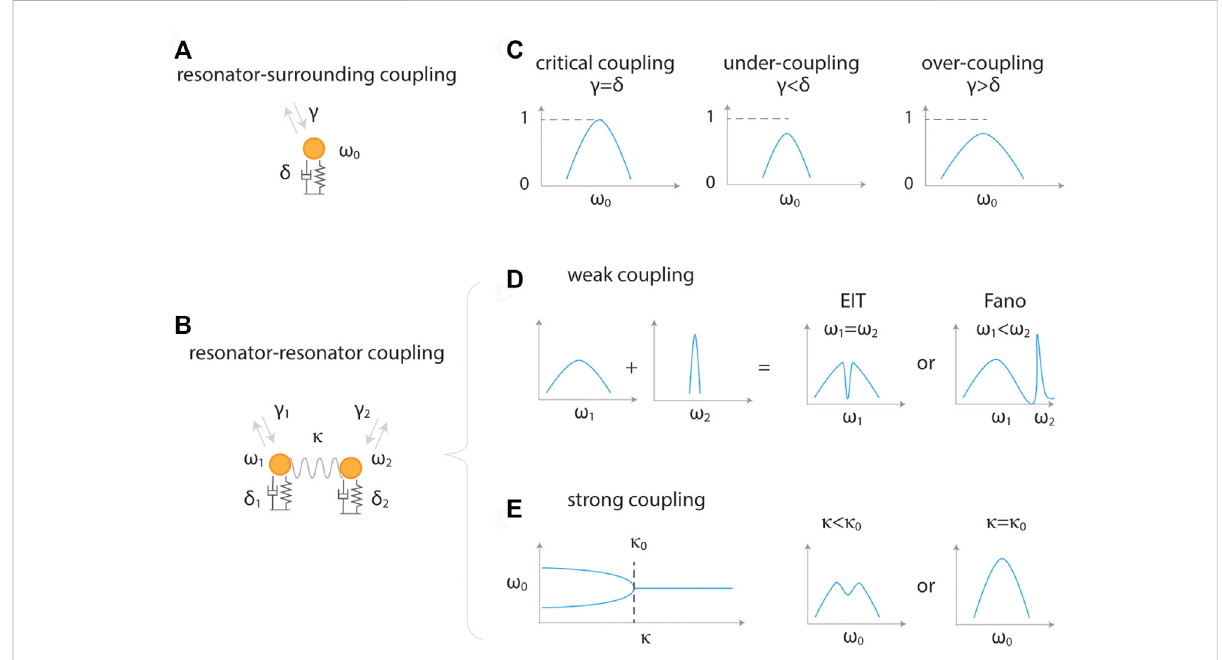
FIGURE 4 Coupling in resonator systems. (A) Coupling between a resonator and environment. (B) Coupling between two resonators. (C) Different couplingregimesin (A) ,exhibitingcriticalcoupling( γ = δ ),under-coupling( γ < δ ),andover-coupling( γ > δ ). (D) Weakcouplingregimesin (B) ( κ < | γ 1 + δ κ < | γ δ 1 |or 2 + 2 |)showingEITandFanoresonance. (E) Strongcouplingregimesin (B) (